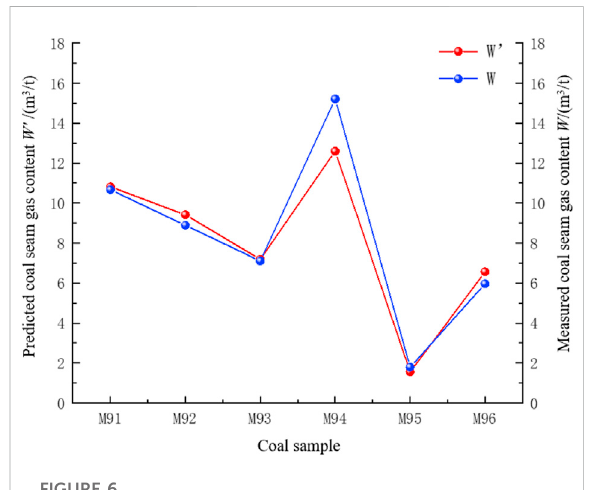
FIGURE 6 Comparison of predicted value W ’ and measured value W of coal seam gas